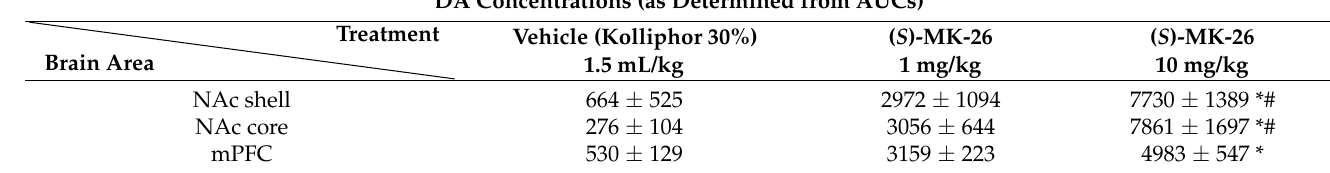
Table 2. Overall assessment of the effect of ( S )-MK-26 on DA concentrations in the NAc shell, NAc core and mPFC dialysate, as measured by the AUCs calculated from the data shown in Figures 4 and 5. AUCs values are expressed as mean ± SEM. One-way ANOVA followed by Bonferroni’s multicom- parison test. *: p < 0.05 vs. vehicle-treated rats; #: p < 0.05 vs. 1 mg/kg-treated rats. DA Concentrations (as Determined from